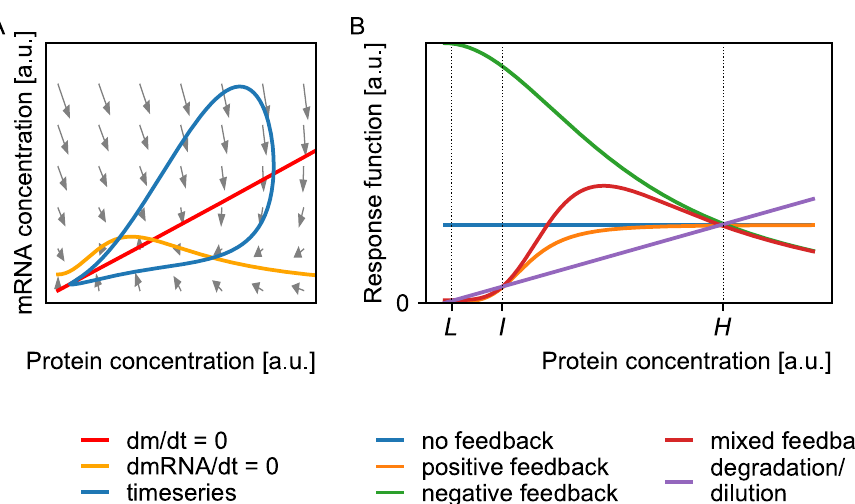
Fig 1. Conceptual representation of the two hypotheses. (A) Oscillations: a non-monotonic response curve, together with implicit delay can give rise to oscillatory behavior. A non-monotonic response, i.e. the mRNA production is non- monotonic with respect to the protein concentration ( m ), results in a non-monotonic nullcline (dmRNA/dt = 0). With sufficient delay (implicit or explicit), the steady state which is the intersection of both nullclines (dm/dt = 0 and dmRNA/dt = 0) becomes unstable and the time series becomes a clockwise oscillation in the phase plane. The grey arrows denote local velocities under the assumption of quasi steady state for the remaining variables, i.e. the DNA states and dimer concentration. (B) A fast bistable switch: Steady state is obtained when the production rate (feedback) and removal rate (degradation/dilution) are equal. For concentrations where the feedback is bigger than the degradation/dilution, the concentration will increase, for concentrations where the feedback is smaller than the degradation/dilution, the concentration will decrease. Positive feedback can lead to bistability, i.e. there is a low ( L ) and high stable steady state ( H ), the intermediate state ( I ) is unstable. Because the instantaneous speed of the reaction is the difference of the response function and the degradation/dilution, the induction time to the steady state ( H ) will be smaller for systems with negative feedback than for systems with no feedback. Similarly, mixed feedback can speed up the induction time of a bistable switch, i.e. the time it takes to go from the unstable intermediate state I to the stable high steady state H